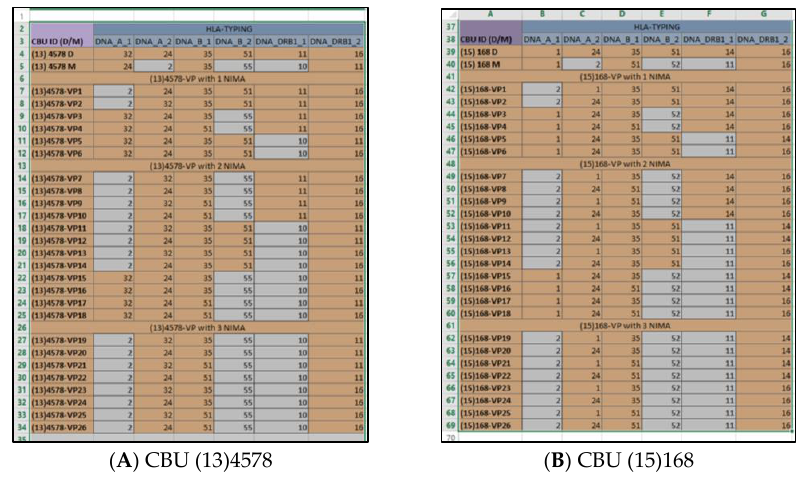
Figure 5. A screenshot of the field of analysis of: ( A ) CBU (13)4578 and ( B ) CBU (15)168, showing HLA-A, B and DRB1 of the CB donor, the mother, and all generated VPs.